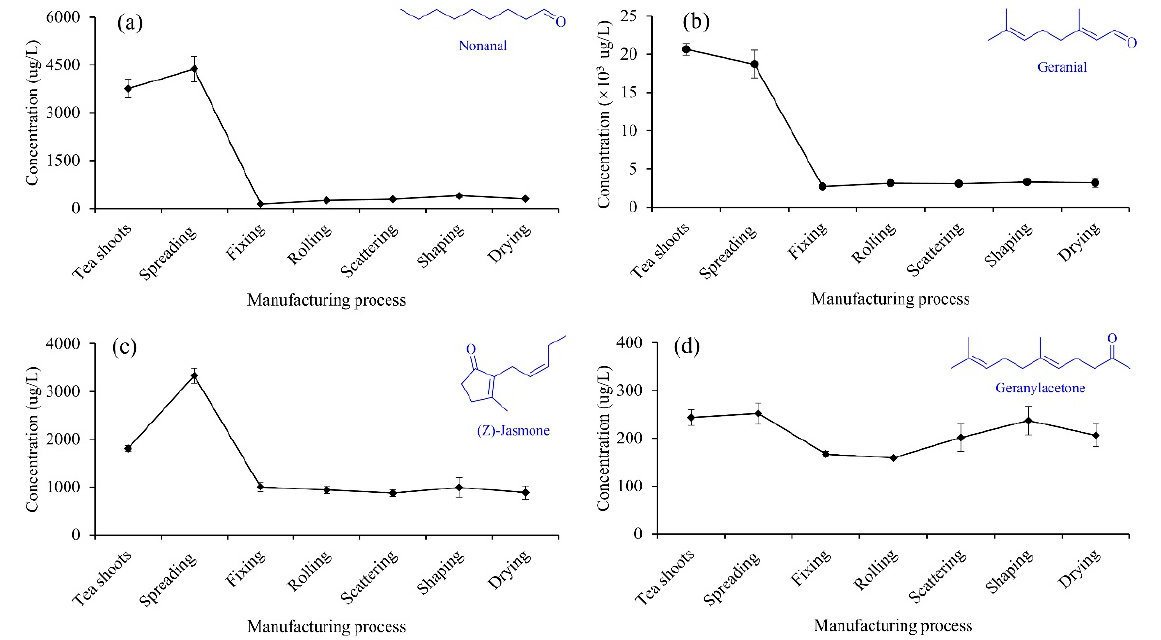
Figure 5. Changes in the concentrations of nonanal ( a ), geranial ( b ), (Z)-jasmone ( c ), and geranylacetone ( d ) during the XYMJ green tea manufacturing.